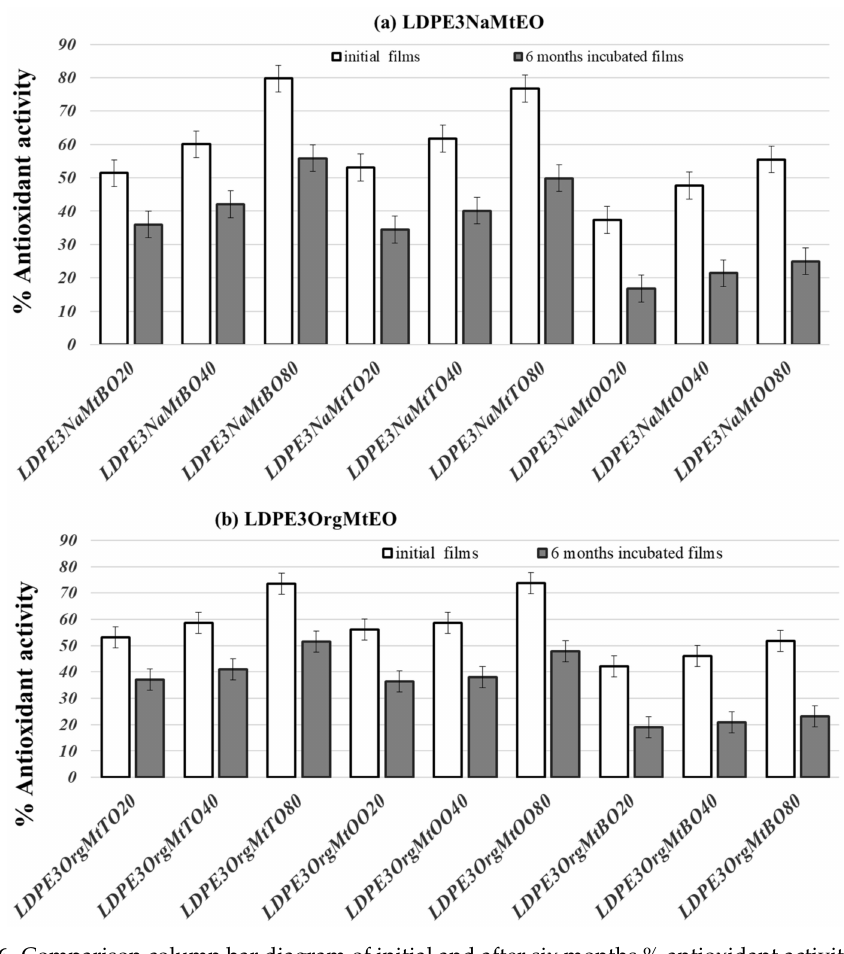
Figure 6. Comparison column bar diagram of initial and after six months % antioxidant activity values of all ( a ) LDPENaMtEO and ( b ) LDPEOrgMtEO films.